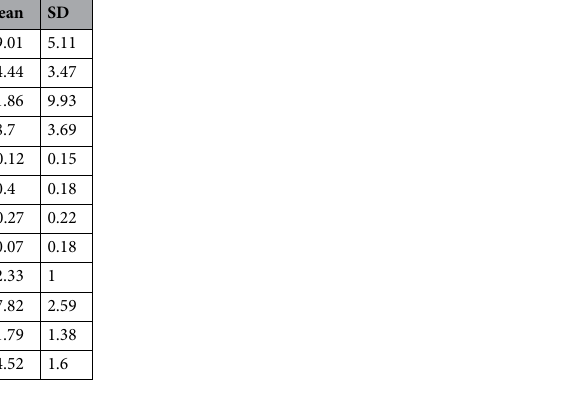
Table 1. Descriptive